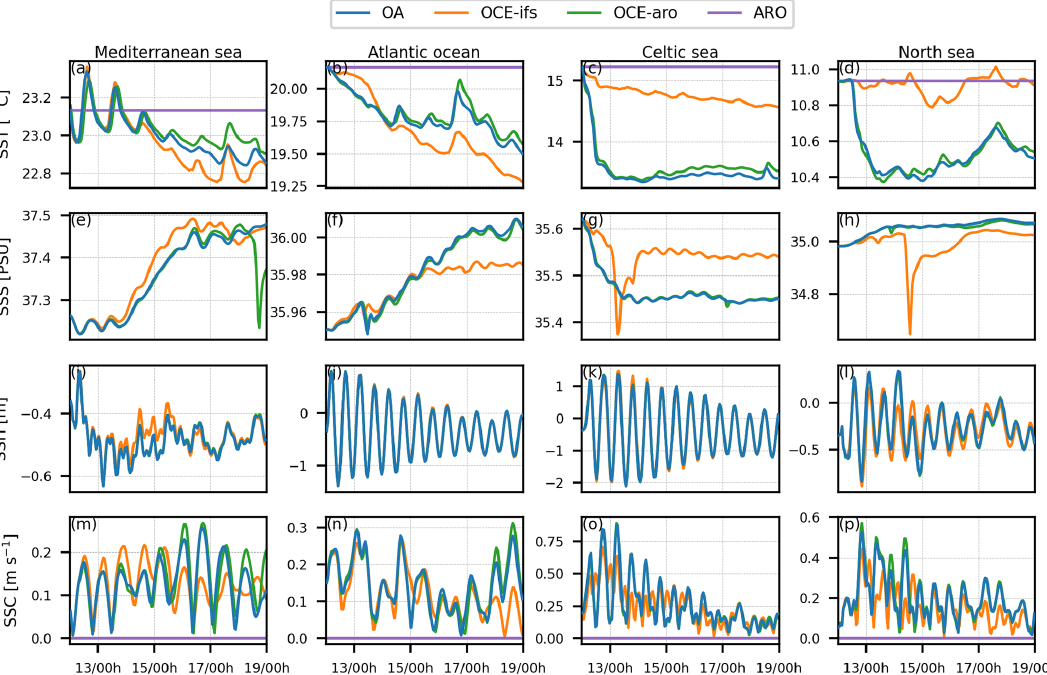
Figure 6. Temporal evolution of simulated sea surface temperature (SST, ◦ C), salinity (SSS, psu), height (SSH, m) and current speed (SSC,ms − 1 ) extracted in the four areas presented in Fig. 3d. Note that ARO does not have SSS or